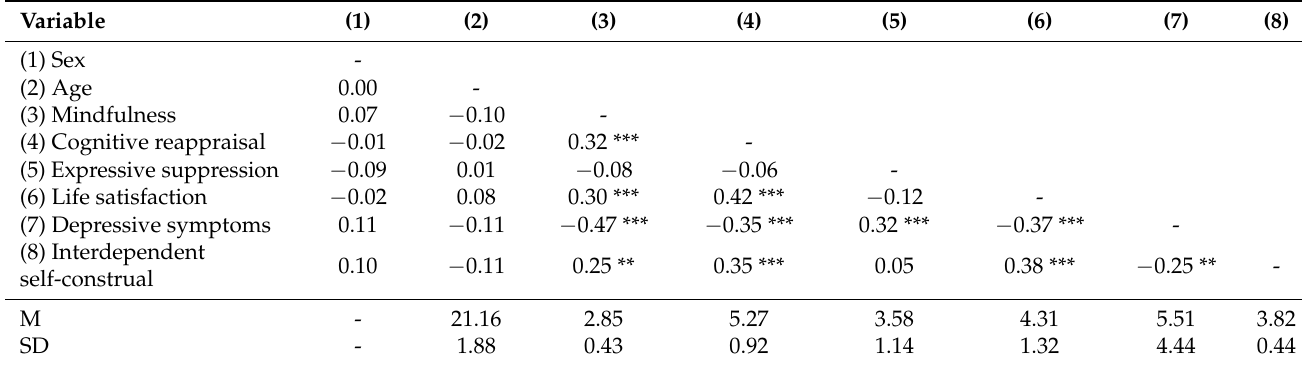
Table 1. Zero-order correlations, means, and standard deviations of the variables under study ( N =